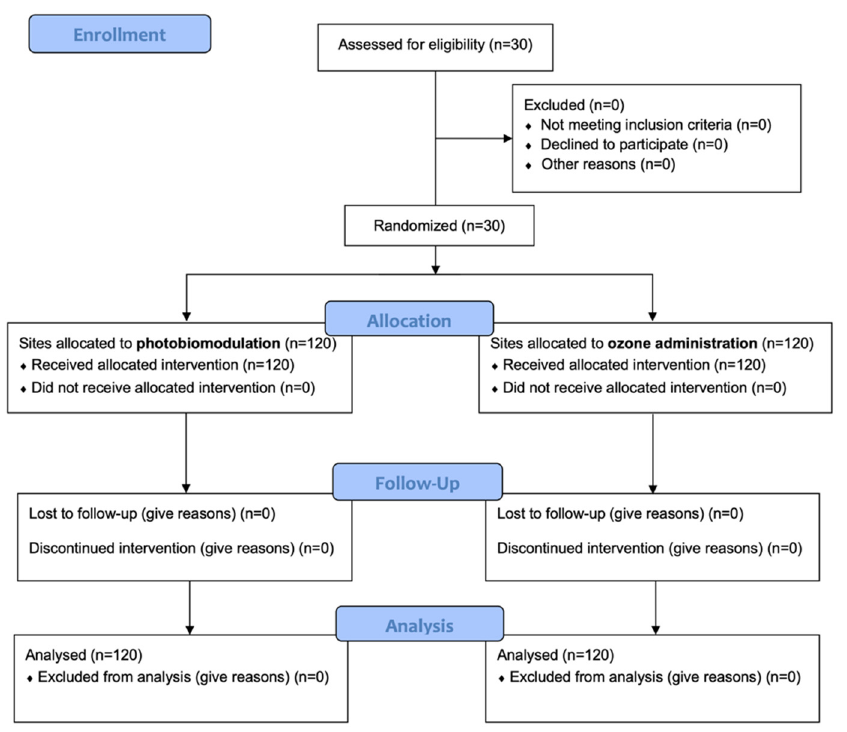
Figure 2. CONSORT flow-chart of the study.